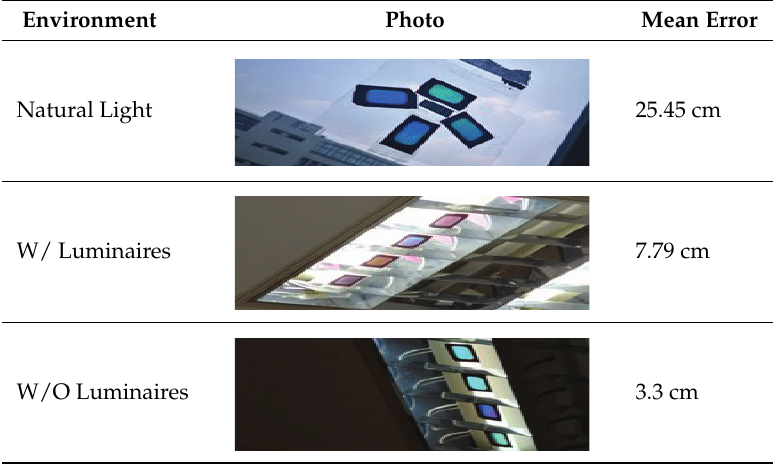
Table 1. Different color polarizer relative